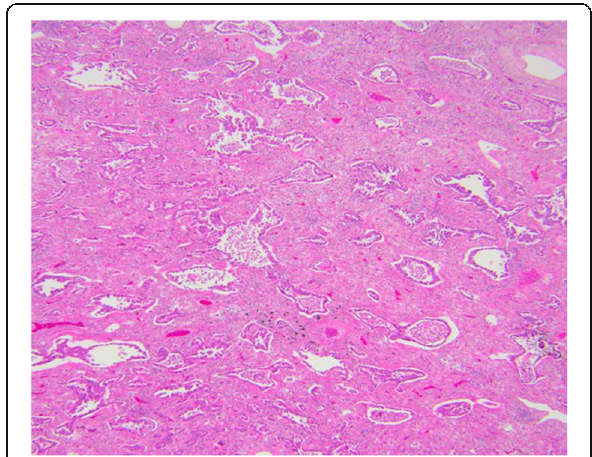
Fig. 9 Lepidic predominant adenocarcinoma histopathology: a 25- mm maximum diameter lepidic predominant adenocarcinoma